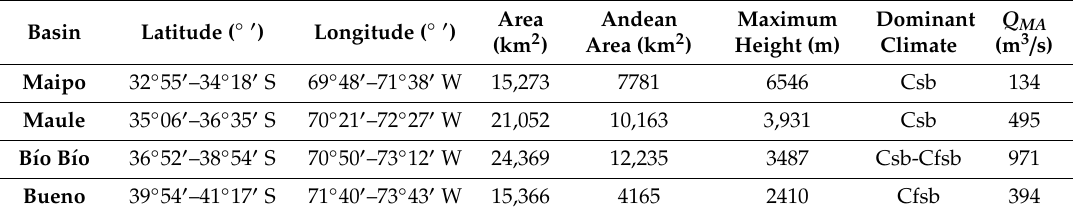
Table 1. Location, geomorphological and climate data for each basin in the study area. 170